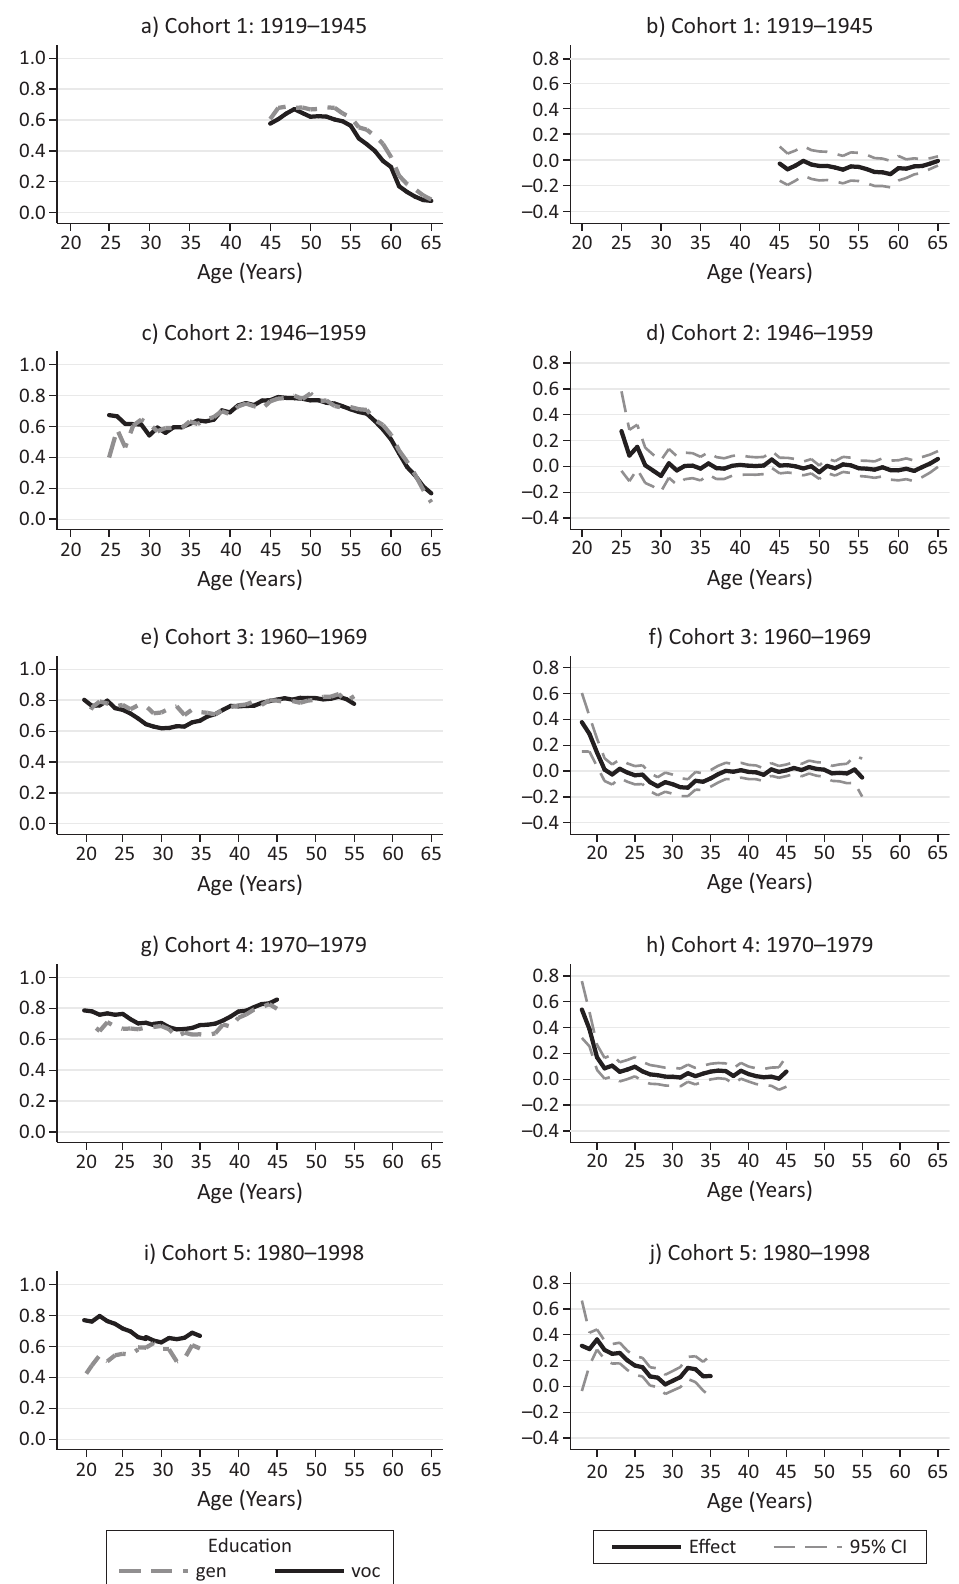
Figure A5. Cohort variation in employment opportunity over the life course: General versus vocational education, net of double qualifications (men). Notes: Conditional profile plots (left) and conditional effect plots (right) estimated by cohort- specific non-parametric state probability models of vocational and general education on employment probabilities of men. Control variables include period effects, German nationality, parental educational background, residence in West Germany, and educational level. Detailed regression results available upon request. Data source: GSOEP